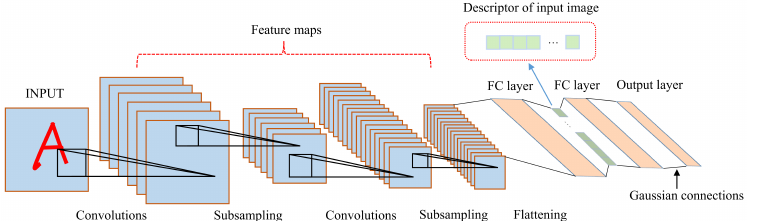
Figure 3. Sketch map of the feature maps obtained by LeNet-5 [25]. The descriptor of input image is generated in the second stage of neural